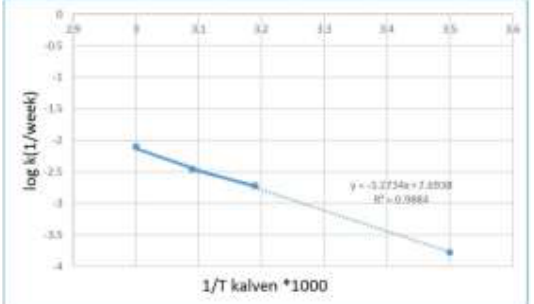
Figure 16. Arrhenius plot of the prepared risperidone in the selected F13 lyophilized powder for estimation of the expiration